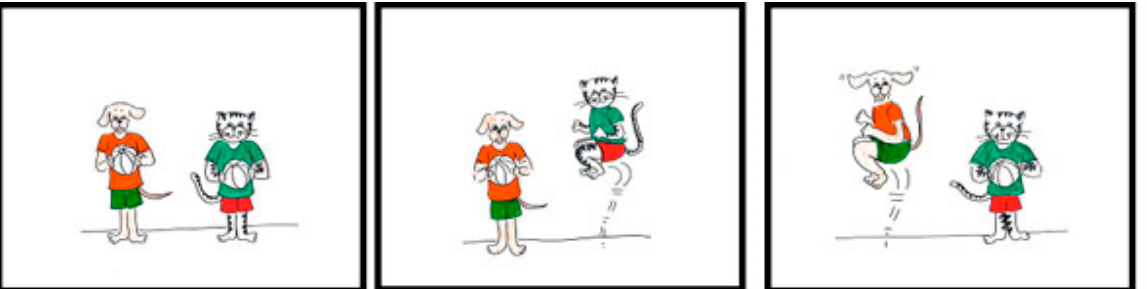
Figure A1. Practice stimulus 1. El perro salta una y otra vez.